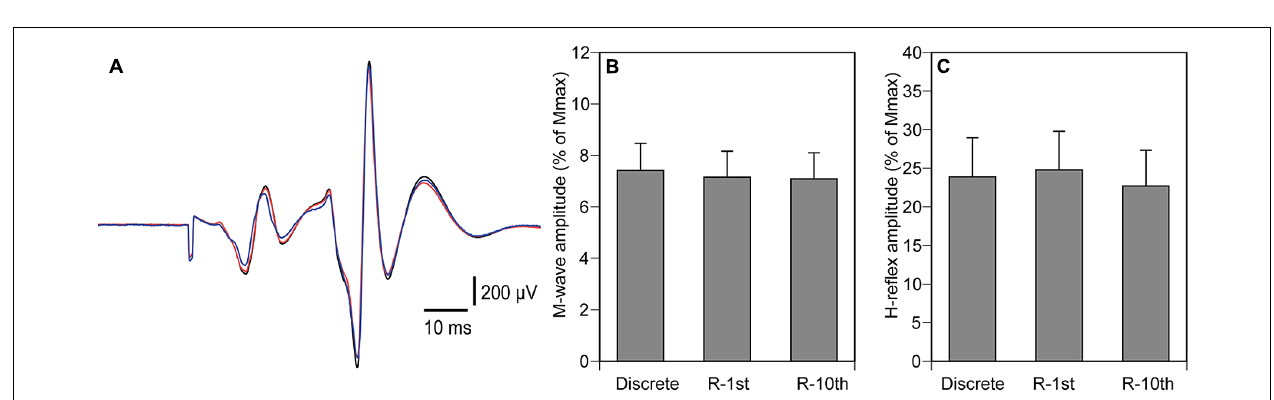
FIGURE 5 |Averaged H-reflex from a representative subject (A), overall averages of M-wave amplitude (B) and H-reflex (C). The black trace indicates H-reflex in the discrete movement condition, the red trace indicates H-reflex in the R-1st condition, and the